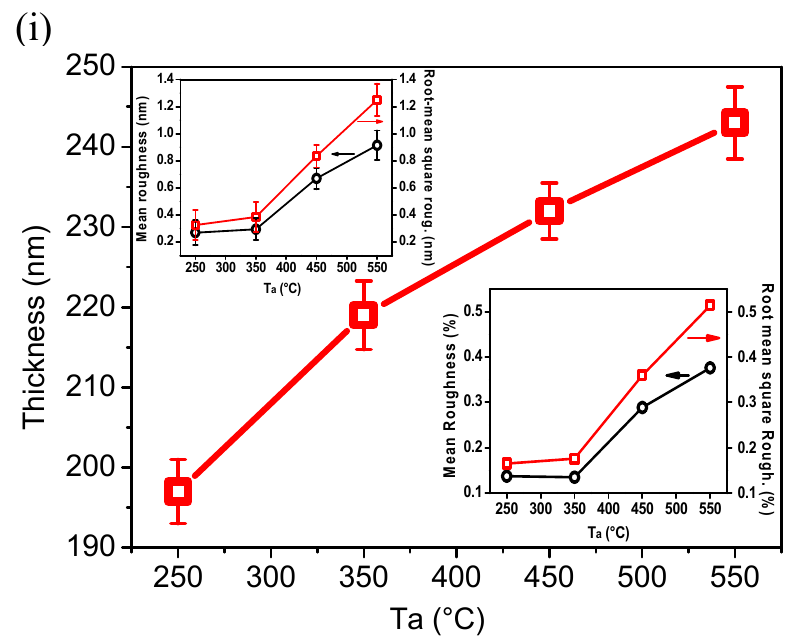
Figure 6. Three-dimensional atomic force microscopy (AFM) images of ZrO 2 thin films of annealed at different temperatures: ( a ) 250 °C, ( c ) 350 °C, ( e ) 450 °C, and ( g ) 550 °C. Roughness was taken over areas of 2 μ m × 2 μ m of the coatings at ( b ) 250 °C, ( d ) 350 °C, ( f ) 450 °C, and ( h ) 550 °C. ( i ) Thicknes versus annealing temperatures (Ta), the upper inset shows the mean roughness (MR) and the root mean square roughness (RMSR) vs. Ta. Lower inset shows MR and RMSR in percent values vs. Ta.